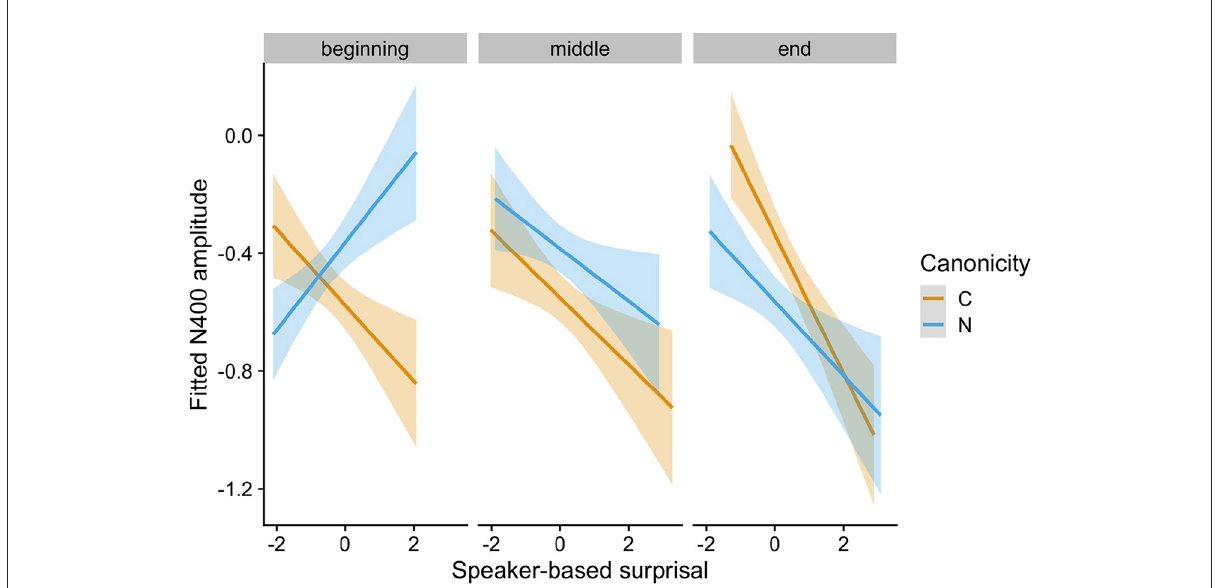
FIGURE3 Changes in the relationship between speaker-based surprisal (z-transformed) and N400 amplitude over the course of Experiment 1 for canonical (C) and non-canonical (N) adjective orders. The figure visualizes partial effects as calculated using the remef package, adjusted for prestimulus amplitude. Note that position in the experiment (operationalised via epoch in the statistical model) is trichotomised into beginning, middle and end for visualization purposes only; epoch was included in the model as a continuous